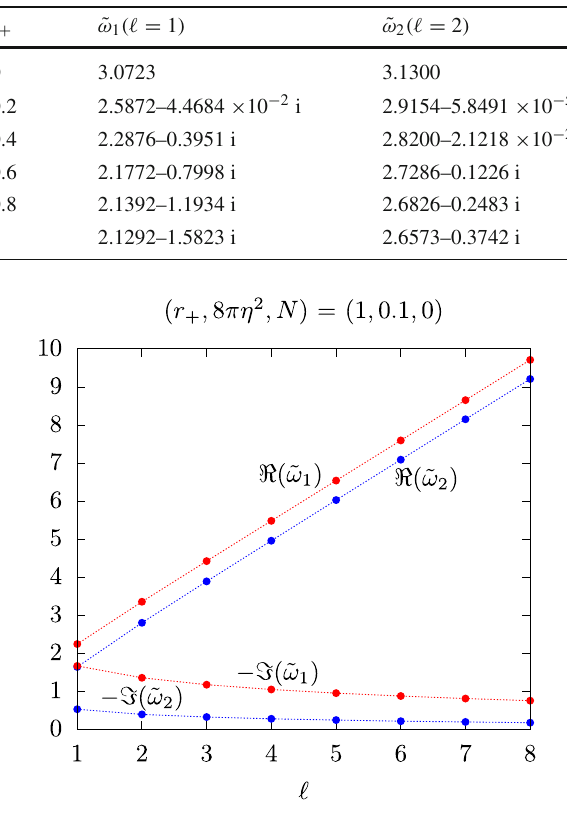
Fig. 2 The impact of the angular momentum quantum number (cid:2) on the real and imaginary parts of quasinormal modes for the first (red) and second (blue) boundary conditions ˜ L , Eq. (9) By taking the unit of